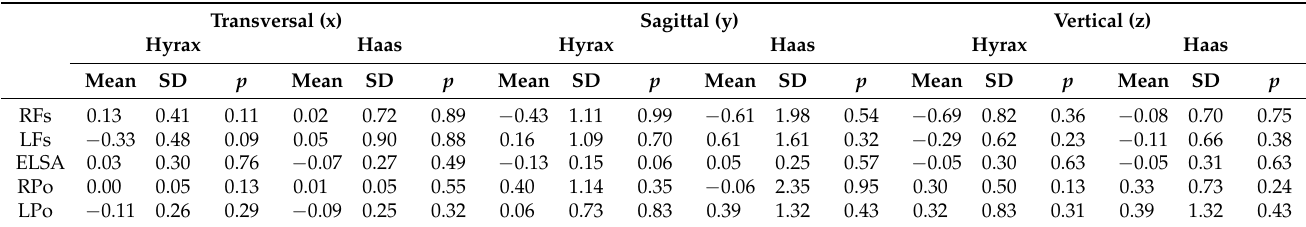
Table 4. Intragroup comparison of cranial references observed in all three directions of space (x, y, and z axes) for both Hyrax and Haas group ( p < 0.05). Transversal (x) Sagittal (y) Vertical (z)